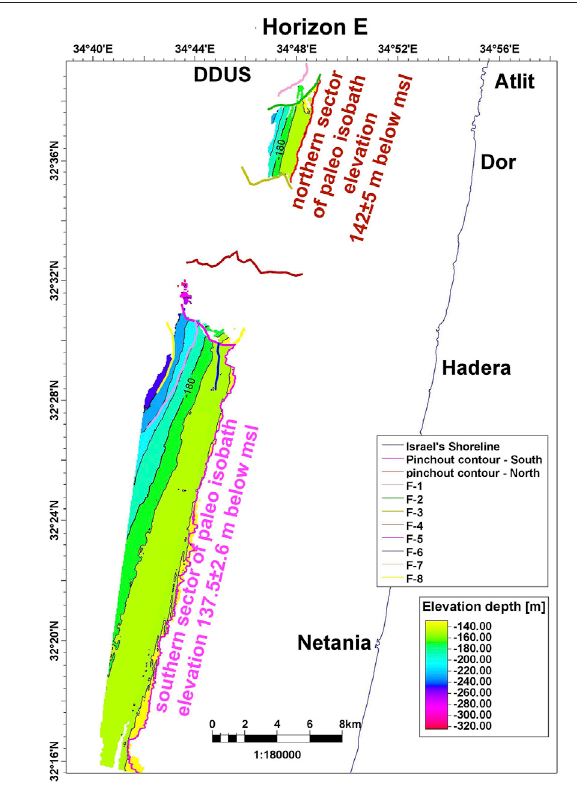
FIGURE 10 | Seismic mapping of Horizon